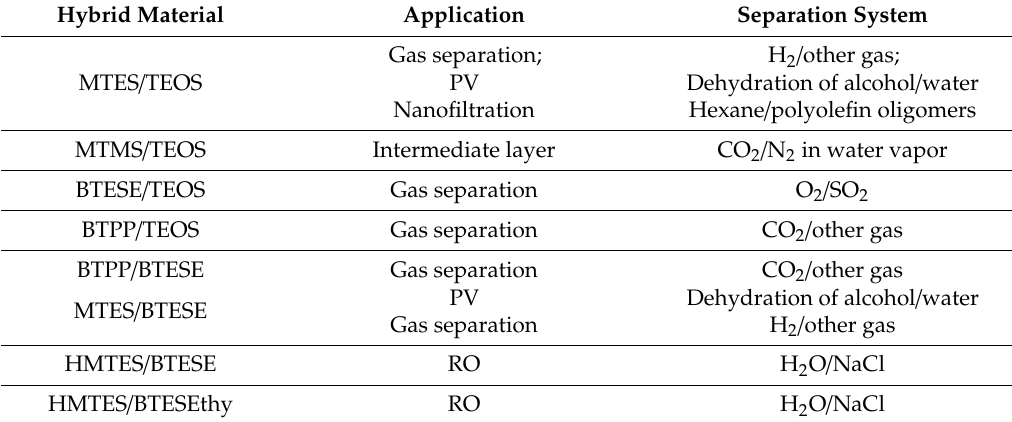
Table 6. The main reported hybrid membranes and their